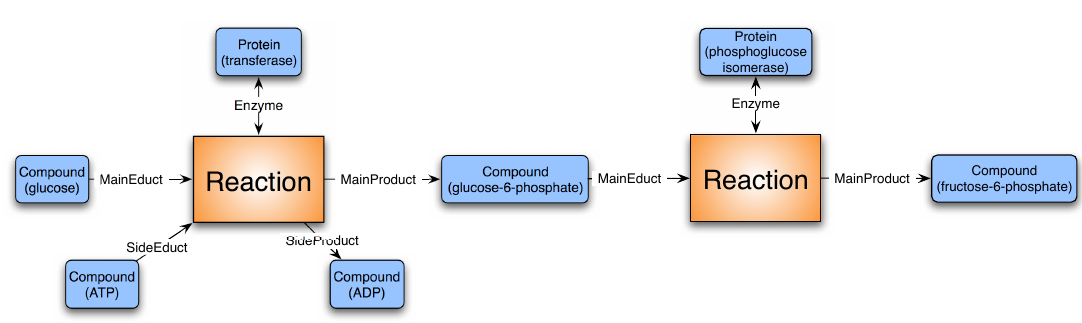
Figure 3: Modeling of the fi rst two steps in the glycolysis as enzymatic reactions in BioCore. Blue boxes stand for participants, orange boxes for events, and the edges (arrows) are labeled with the roles the participants play in the particular reaction. For clarity, each participant is labeled with its name (shown in